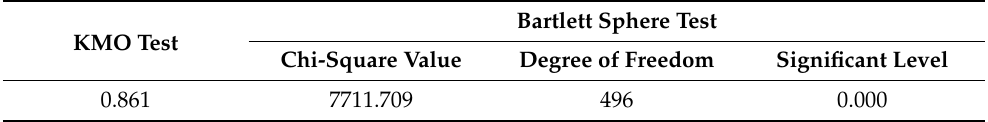
Table 3. KMO and Bartlett sphere